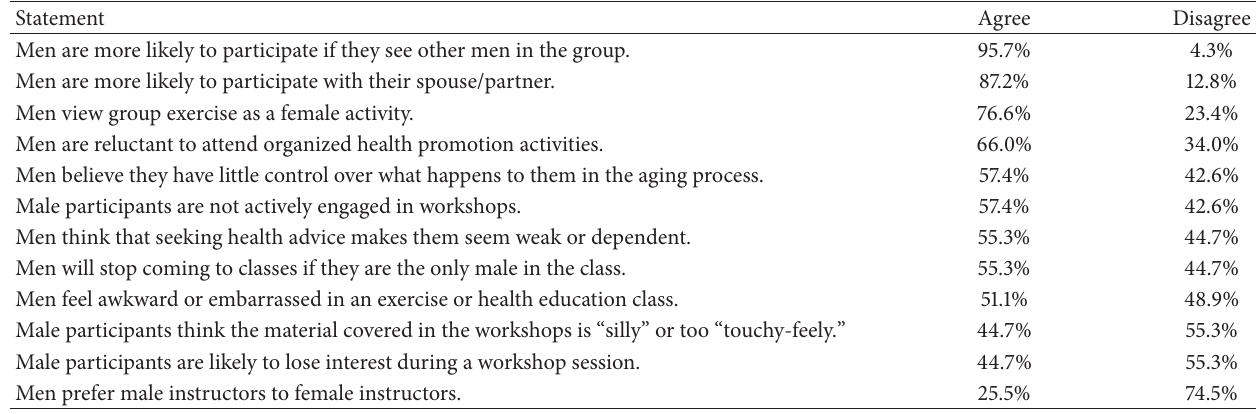
Table 2: Agreement with statements regarding men’s beliefs and participation.